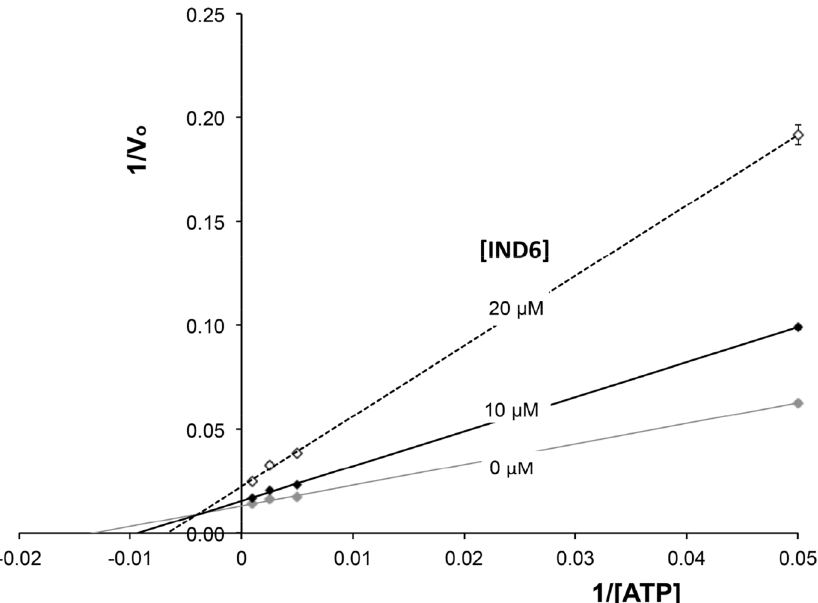
Figure 1. Lineweaver–Burk (double reciprocal) plot showing inhibition of AMPK (α1β1γ1) phosphorylation of SAMS peptide at two fixed IND6 concentrations (10 and 20 µM). Assays were performed in the presence of varying ATP concentrations (20–1000 µM) and the substrate concentration was kept constant at 0.2 µg/µL. Each point is the mean of two different experiments, each one analyzed in